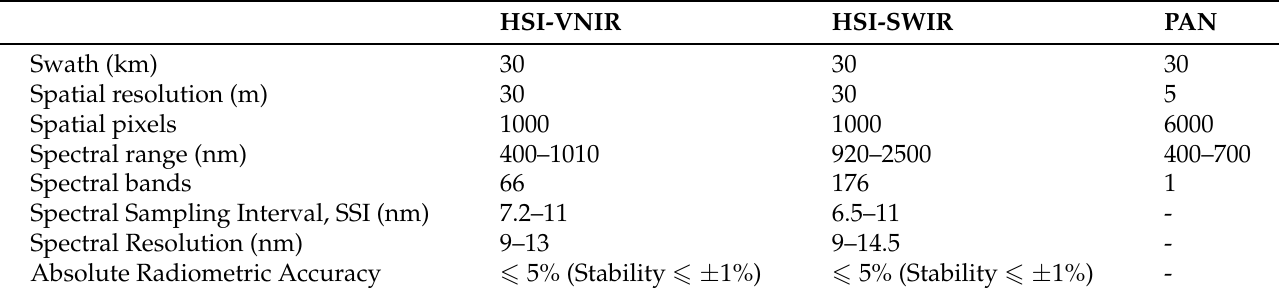
Table 2. Main PRISMA products’ technical